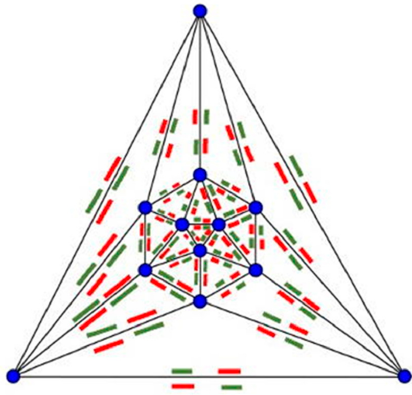
Figure 10. Magnet map on a Schlegel diagram of an icosahedron.